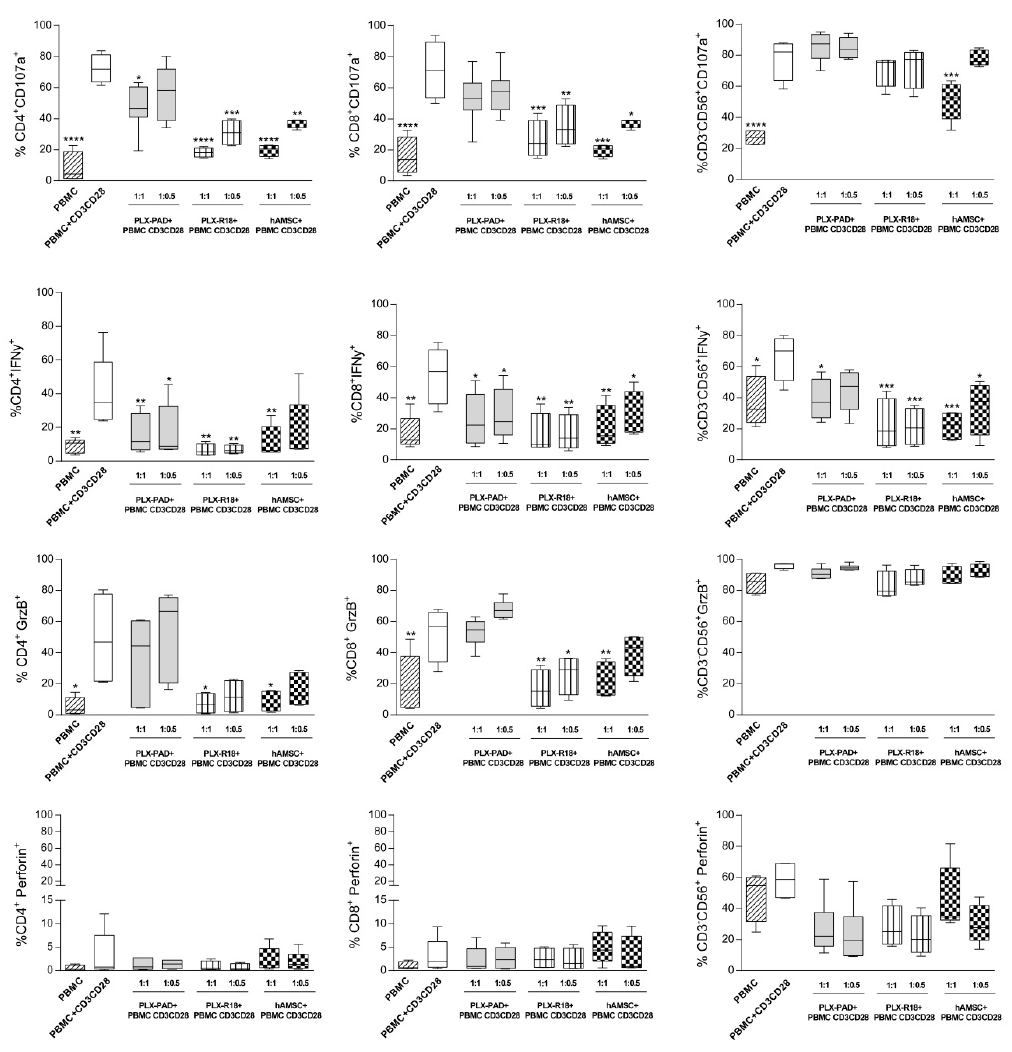
Figure 3. Cytotoxic activity marker expression by T lymphocytes and NK cells after interaction with PLX-PAD cells. Allogeneic PBMC were incubated with anti-CD3/CD28 antibodies in the presence of 2 ratios (1:1 and 1:0.5) of maternal (PLX-PAD)-derived or fetal (PLX-R18 or hAMSC)-derived cells. After two days of culturing, PBMC were activated with PMA+Ionomycin and Golgistop was added 1 h later and, 4 h later, the cells were collected and stained. The frequency of CD107a, IFN- γ , Granzyme B (GrzB + ), and Perforin positive cells (Perforin + ) within the CD4 + , CD8 + T cell, and CD3 − CD56 + NK cell population was assessed by flow cytometry. PBMC alone or incubated with anti-CD3/CD28 mAbs only were used as controls. Results are displayed as mean ± SEM (* p < 0.05, ** p < 0.01, *** p < 0.001, **** p < 0.0001 versus control PBMC+ CD3/CD28), n ≥ 4 individual experiments.